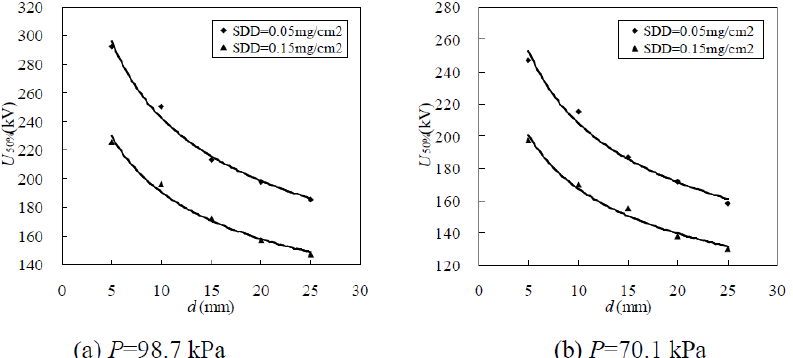
Figure 6. The relationship of U and d of XZP-300 insulator strings covered with ice ( N = 15). 50%